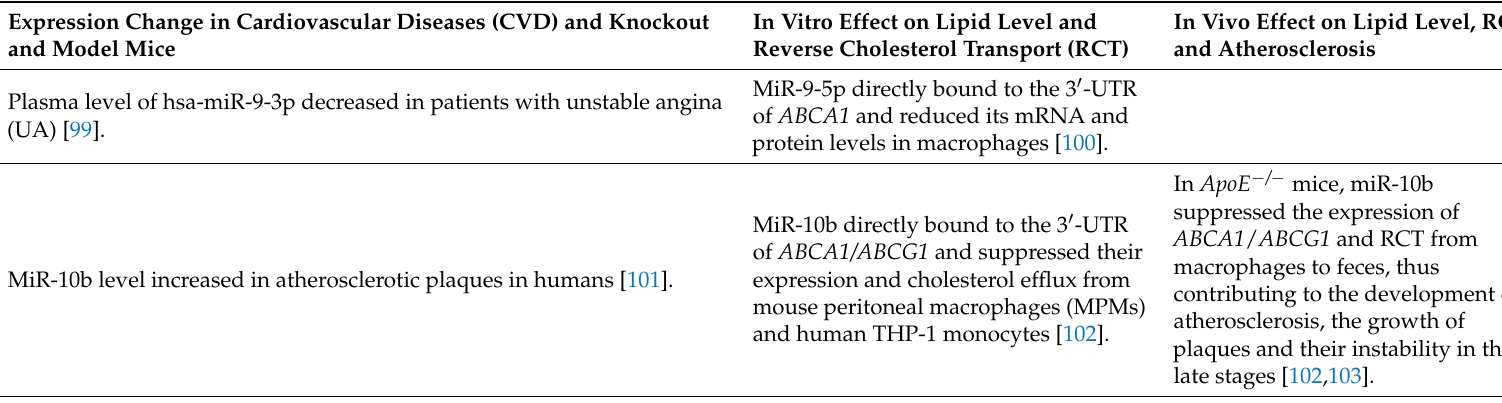
Table 2. MiRNAs regulate the expression of ABCA1 , ABCG1 , and SCARB1